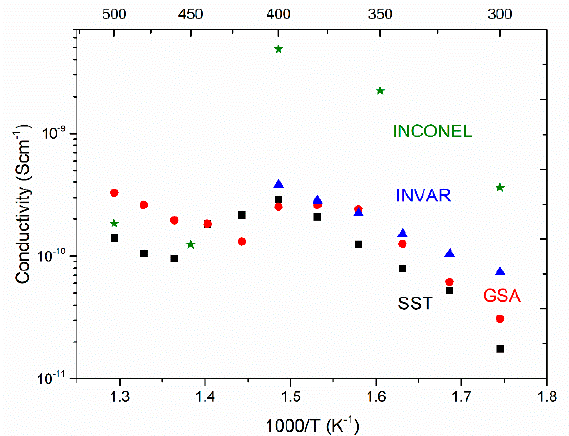
Figure 9. Temperature dependence of total conductivity in barium cerate films deposited on the metallic substrates at 600 °C with 12 Å/s. Conductivity was measured in a dry argon atmosphere. The uncertainty of each measurement is within the thickness of the point.